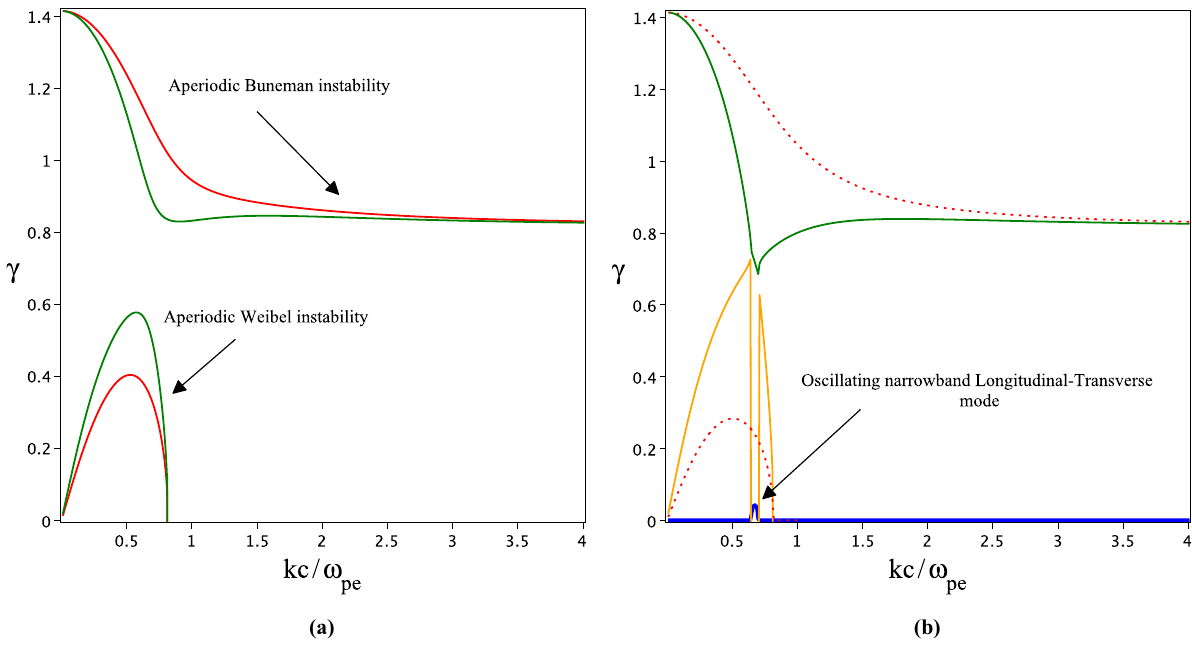
Figure 2. The growth rates of Longitudinal-Transverse instability in coupled limit. ( a ) Red and green lines indicate growth rates ( γ = Im ¯ ω ) of Weibel and Buneman instabilities in weakly coupled limit for a 0 = 1, 1.3 , respectively. ( b ) Yellow and green lines indicate growth rates ( γ = Im ¯ ω ) of Weibel and Buneman instabilities respectively for a 0 = 1.39 , the blue line shows a small real part of modes frequencies at kc /ω pe ≈ 0.7 . The dot lines plotted instabilities growth rates in the uncoupled regime for a 0 = 1